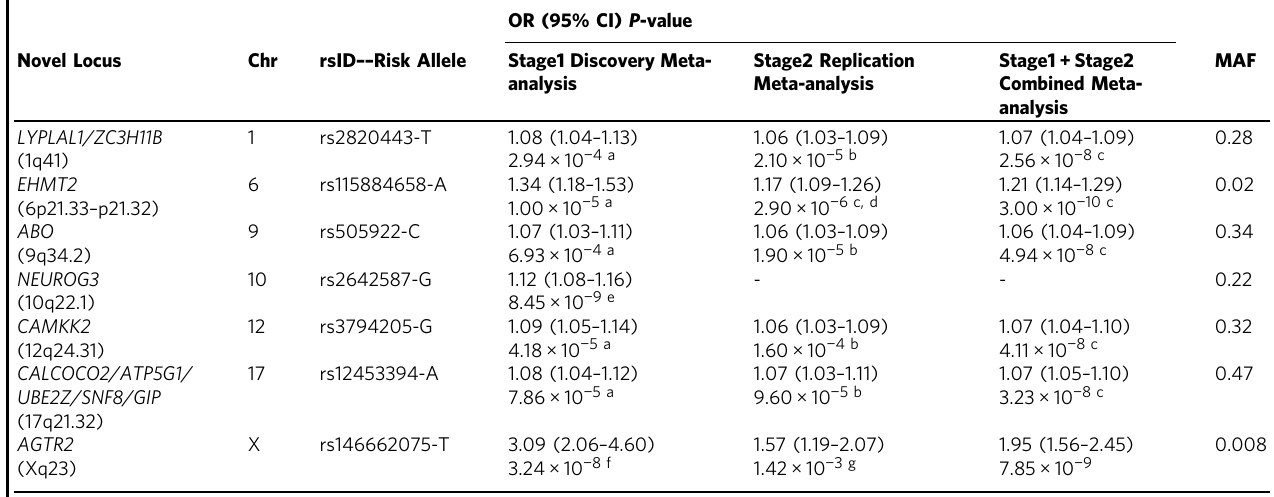
Table 1 Novel T2D-associated loci